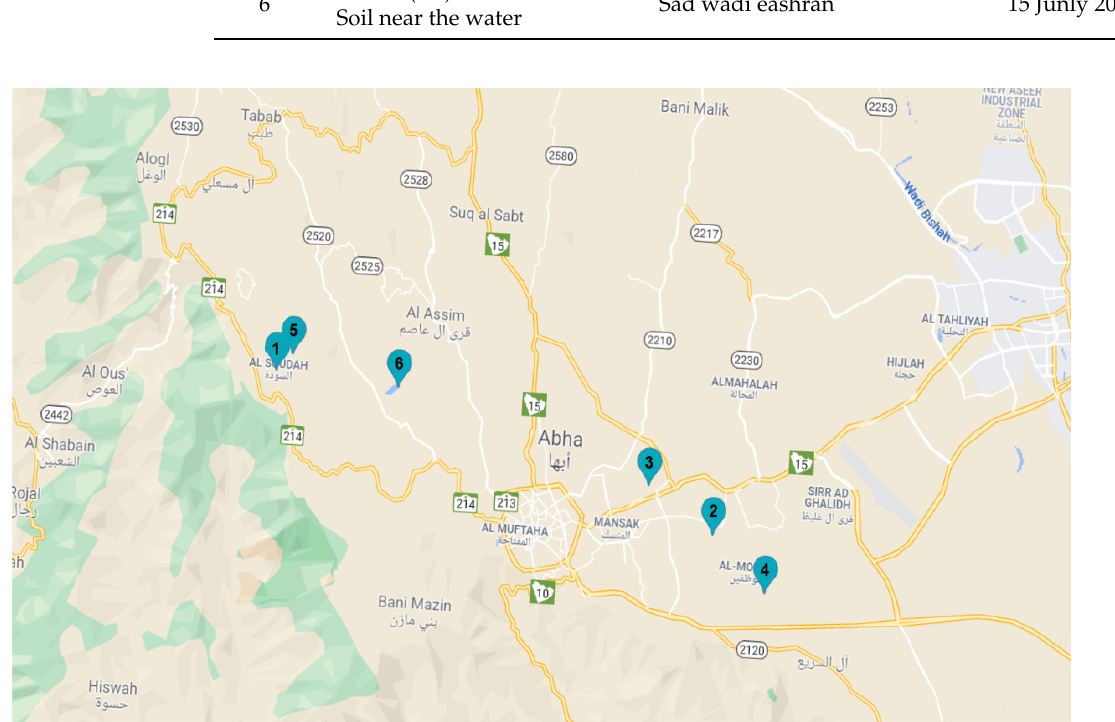
Figure 6. Location of soil samples collections sites, Abha, Saudi